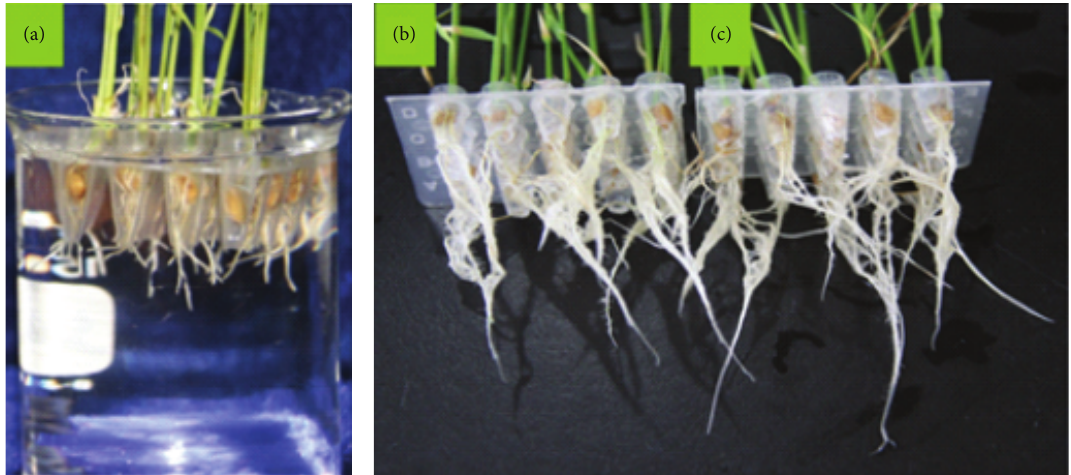
Figure 5: Image of rice roots (a) with pure QDs; (b) without QDs; and (c) with silica coated QDs.